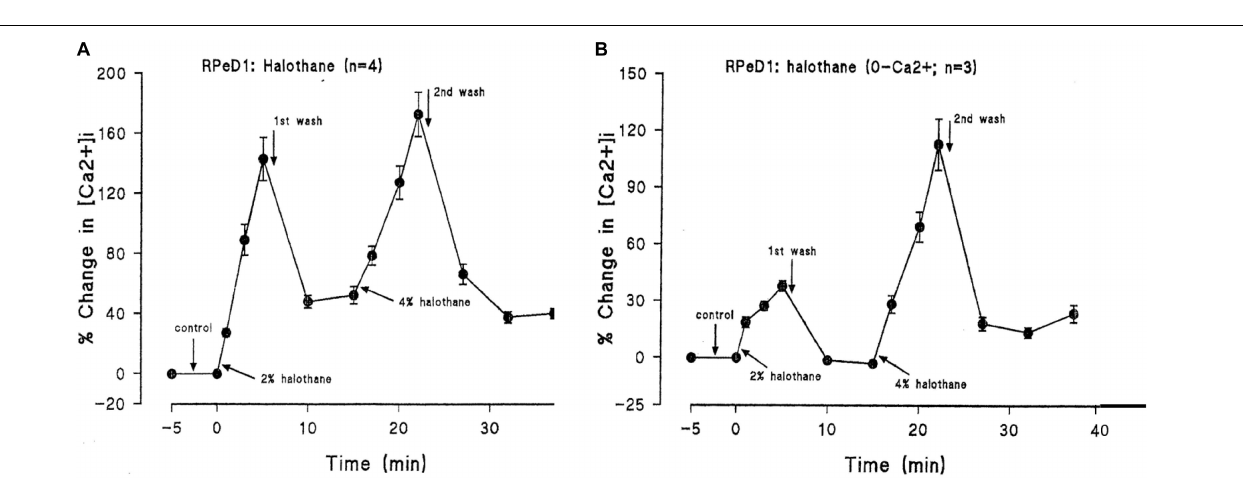
A series of systemic general anesthetics has been applied to identified neurons of Helix aspersa to test their action on ACh-induced inhibition using the voltage clamp